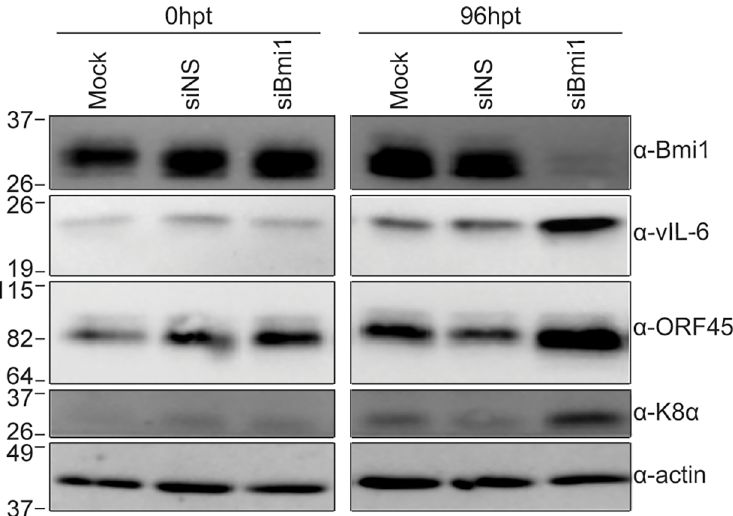
Fig 8. Bmi1 is essential for maintenance of KSHV latency. BCBL-1 cells were mock transfected or transfected with control or Bmi1 siRNAs, and cells were lysed at 0 and 96 hours post-transfection. KSHV lytic proteins were assayed by